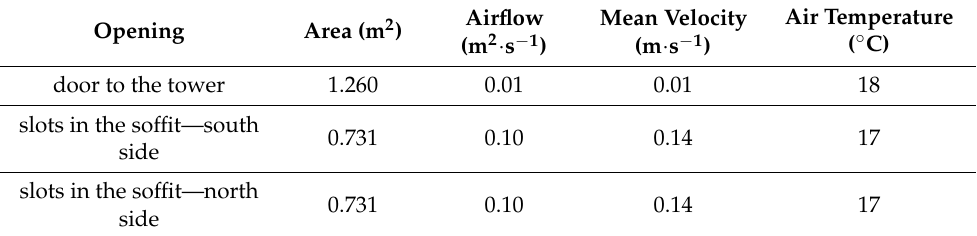
Table 9. Airflow characteristics through the openings at 6:00 a.m. obtained from BPS simulation.